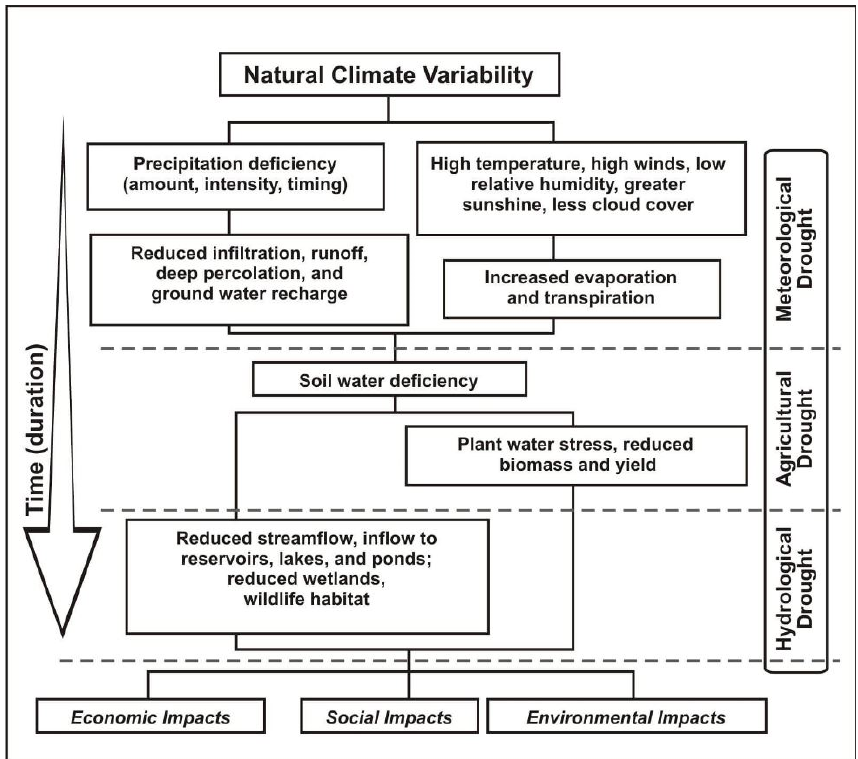
Figure 1. Sequence of drought occurrence and impacts for commonly accepted drought types. Source: http://drought.unl.edu/Education/ DroughtIn-depth/TypesofDrought.aspx, last access: 27 August 2018. Copyright: National Drought Mitigation Center, University of Nebraska-Lincoln,